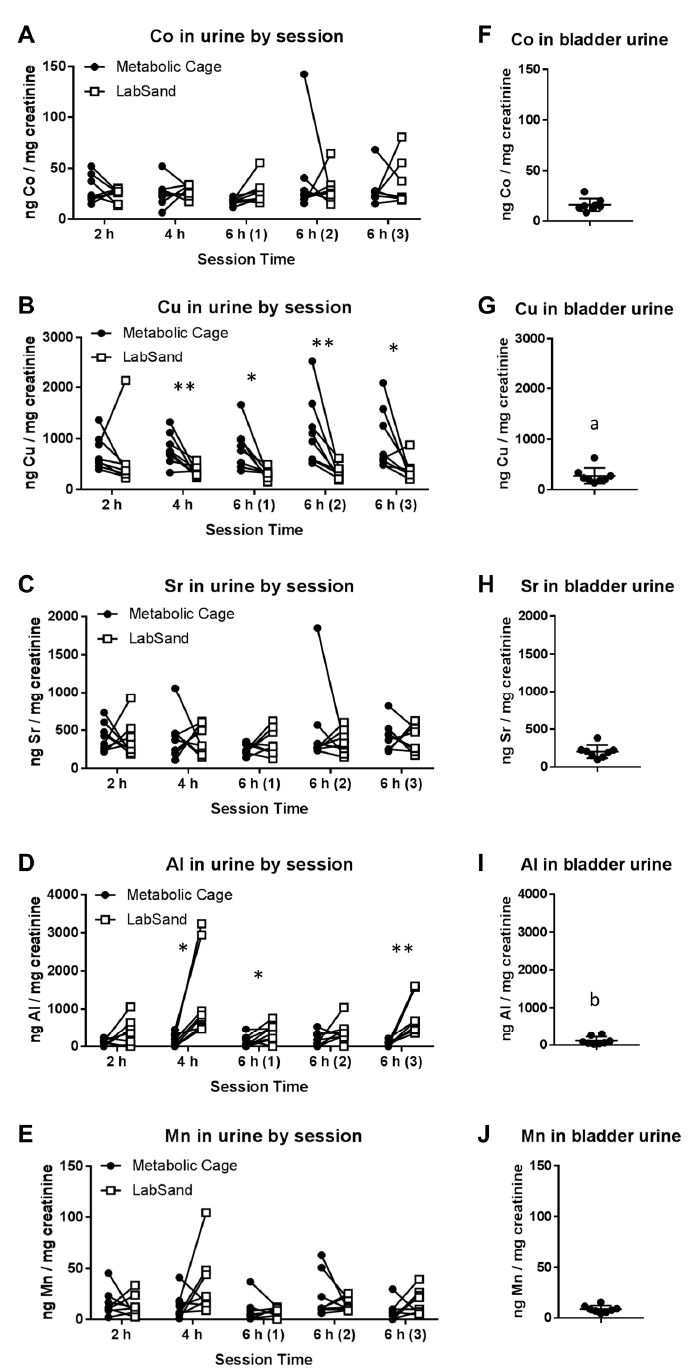
Figure 3. Metal concentrations in urine comparing metabolic cage and LabSand collection methods ( A – E ) and urine collected from the bladder ( F – J ). Graphs ( F – J ) were kept at the same Y -axis value as the corresponding session graph (i.e., A-F, B-G, C-H, D-I, E-J) because bladder urine metal concentrations are directly compared to the 6 h-3 session. Asterisks indicate significant differences in urine metal concentration between collection methods for that session (* p < 0.05, ** p < 0.01), (a) denotes a significant difference in metal concentration between bladder urine and metabolic cage urine from session 6 h-3, and (b) denotes a significant difference in metal concentration between bladder urine and LabSand urine from session 6 h-3.